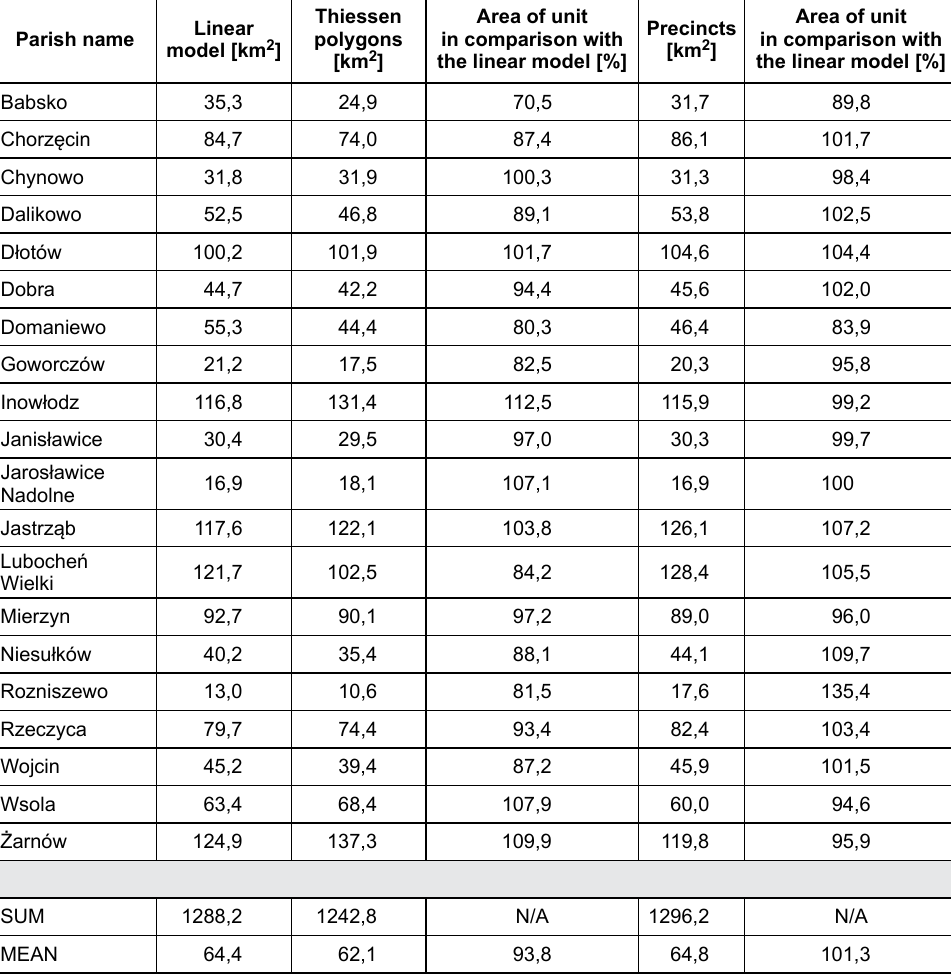
Table 3. Area of units according to analysed methods (20 random parishes)